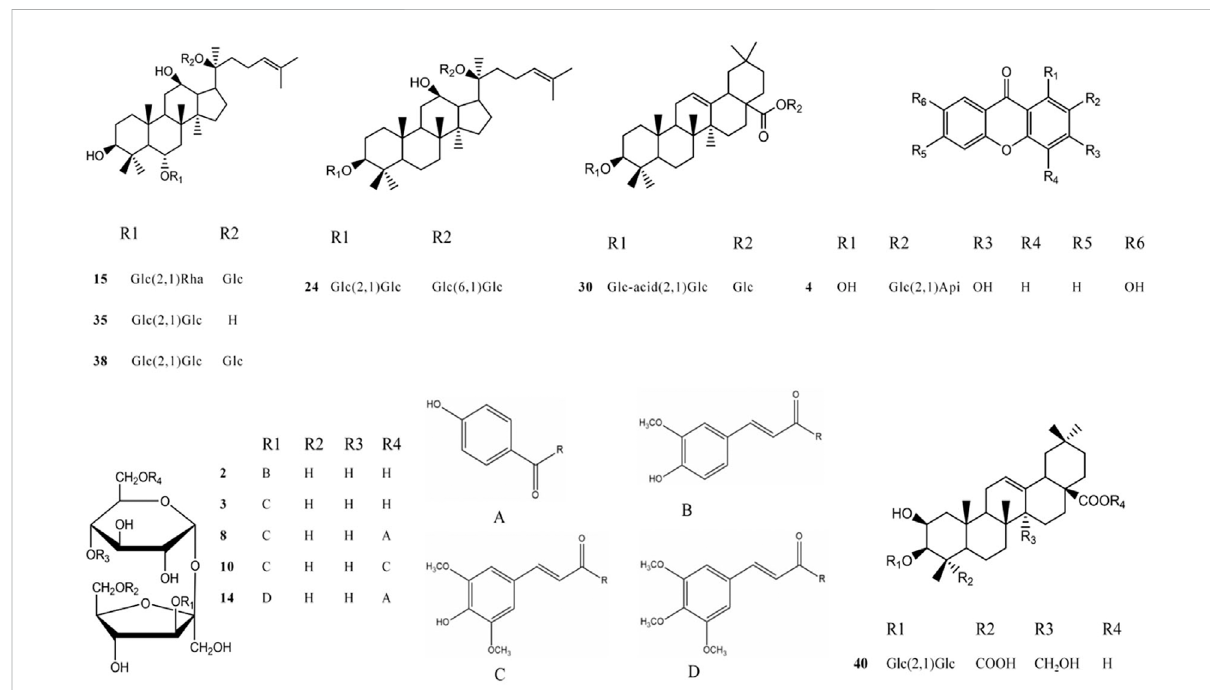
FIGURE 5 The structure of each component of different chemical structures. 2 A5; 3 A6; 4 SB; 8 TenB; 10 3,6 ′ -O-ds; 14 TenA; 15 GRe; 24 GRb1; 30 GRo; 35 GRf; 38 GRd; and 40